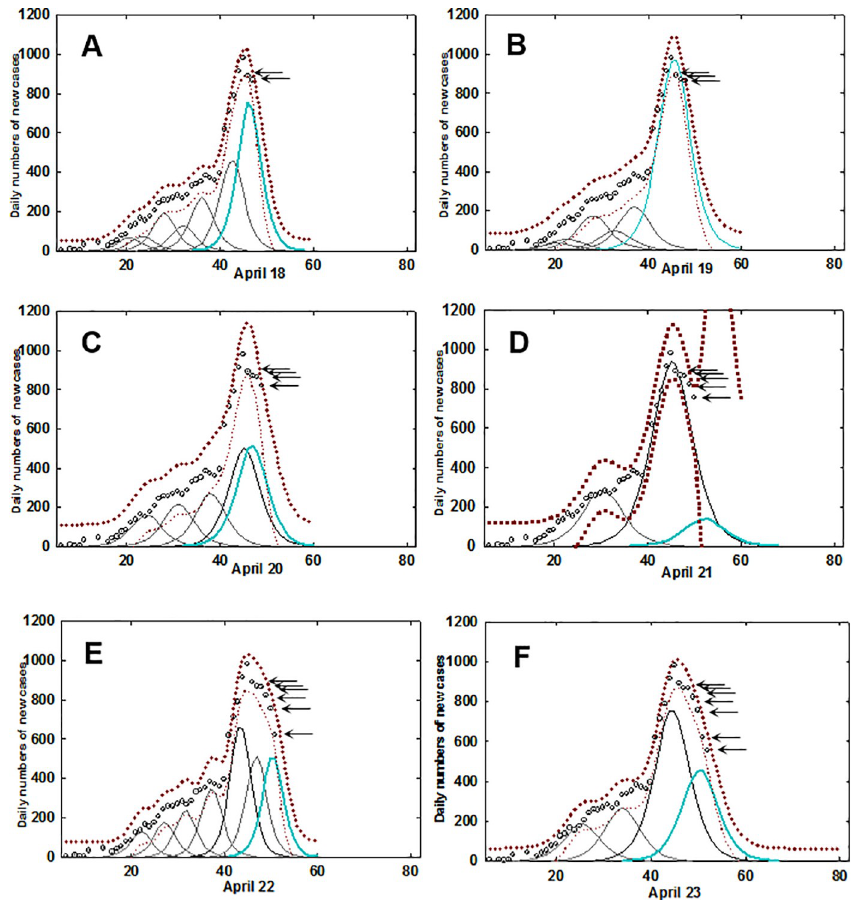
Fig 3. Fitted logistic curves with prediction intervals for Ireland. A-F: Individual daily time course from April 18 to April 23 for data from Ireland. Circle (5-day averaged daily confirmed infections), prediction intervals (brown dotted trace), fitted curves (black), most time recent fitted curve (cyan). Arrows indicate daily new data points. See S1 Movie for the complete dataset.